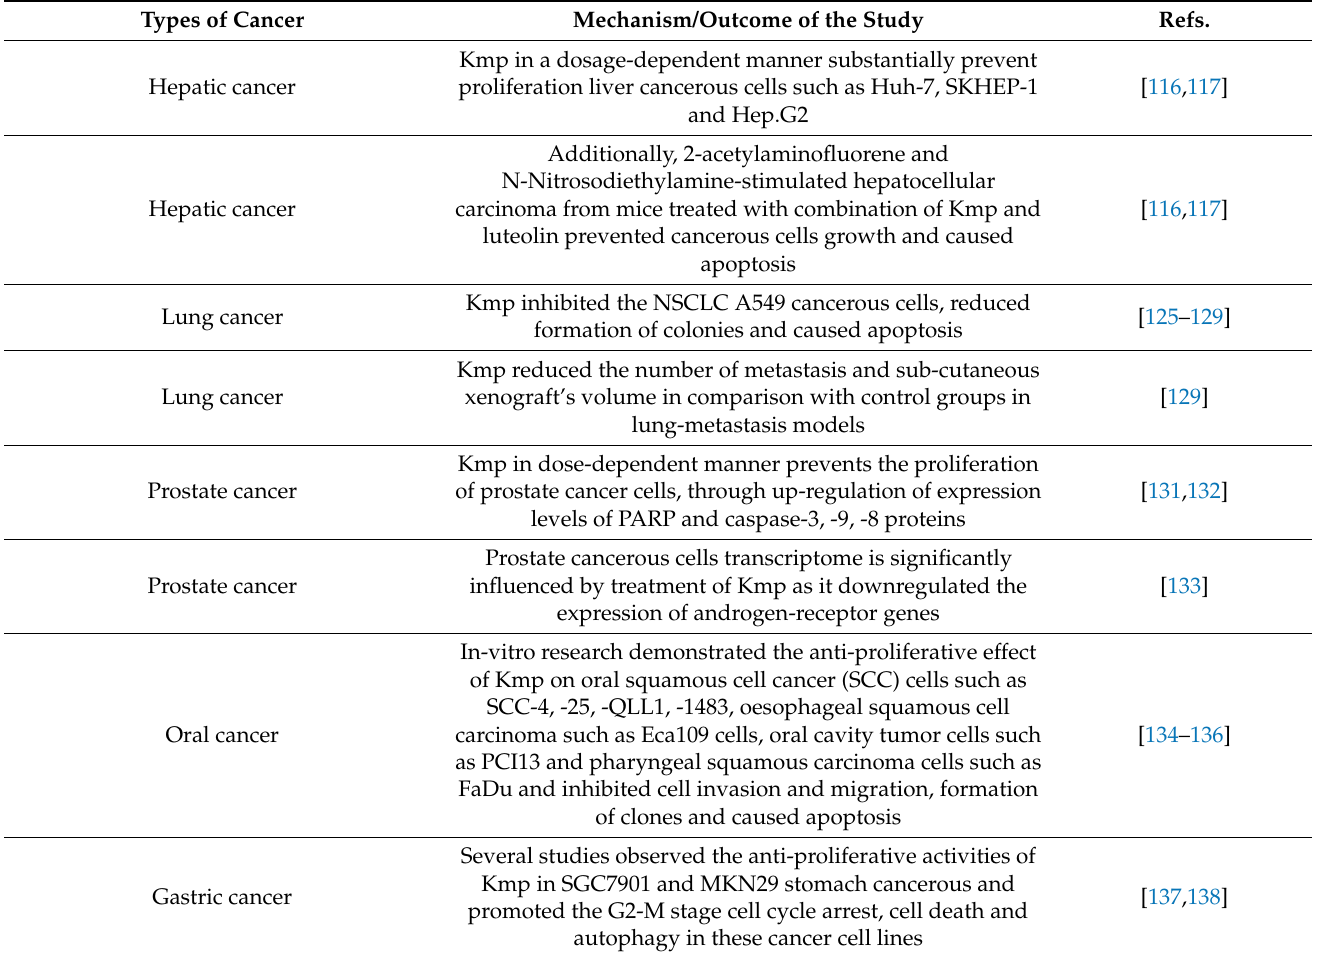
Table 2. Kaempferol (Kmp) role in cancer management through modulating cell signalling pathways. Types of Cancer Mechanism/Outcome of the Study